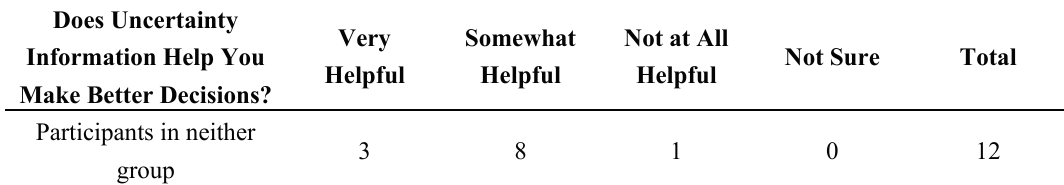
Table A5. Observed frequencies on the helpfulness of uncertainty information for decision making by participants in neither